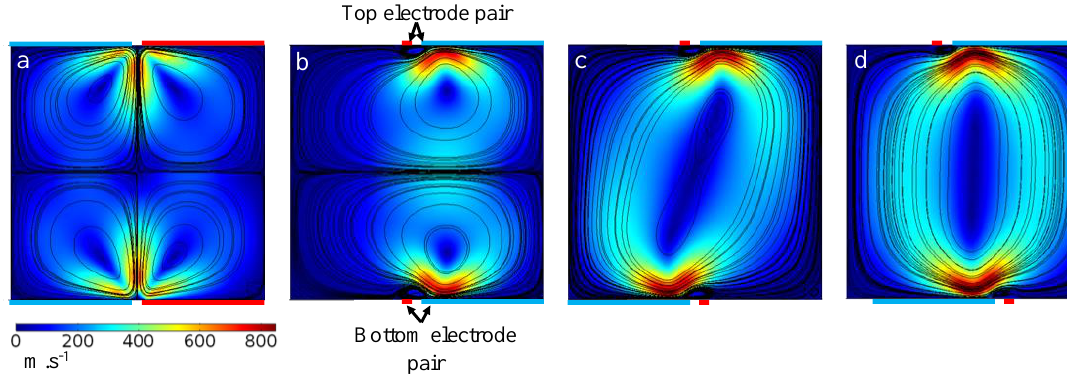
Figure 2. The magnitude of 2D velocity field and flow streamlines are shown in a cross-section of an ACET microfluidic device consisting of longitudinal microelectrodes parallel to the microfluidic channel (coming out of the page vertically). The top and bottom substrates (not shown) contain two ( a ) symmetrical (Design I) and asymmetrical (i.e., ( b ) Design II and ( c ) Design III) microelectrode pairs in contact with the fluid. The electrodes in ( a ) have equal 140 µ m widths, while in ( b – d ) the wide electrode is 120 µ m and the thin one is 20 µ m. The gap width between electrodes for all cases is 20 µ m. Actuated (red) and ground (blue) electrodes are as indicated. As shown, regions of strongest fluid flow are near the gap between the two electrodes. Four and two symmetrical microvortices are generated due to the application of Design I and Design II, respectively, whereas, in Design III, the entire cross-section of the channel is swept by only one set of microvortices. If the electrode pairs in ( c ) are repositioned 20 µ m horizontally towards the center (as shown in ( d )), the resultant streamlines become more circular, sweeping the entire cross-section more uniformly.